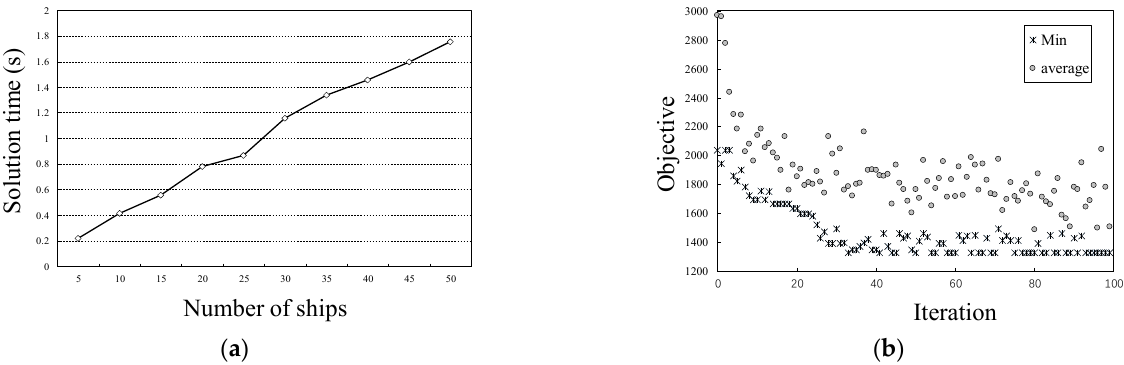
Figure 12. Performance evaluation of the GA. ( a ) Influence of ships on solution time; ( b ) Iterative evolution.